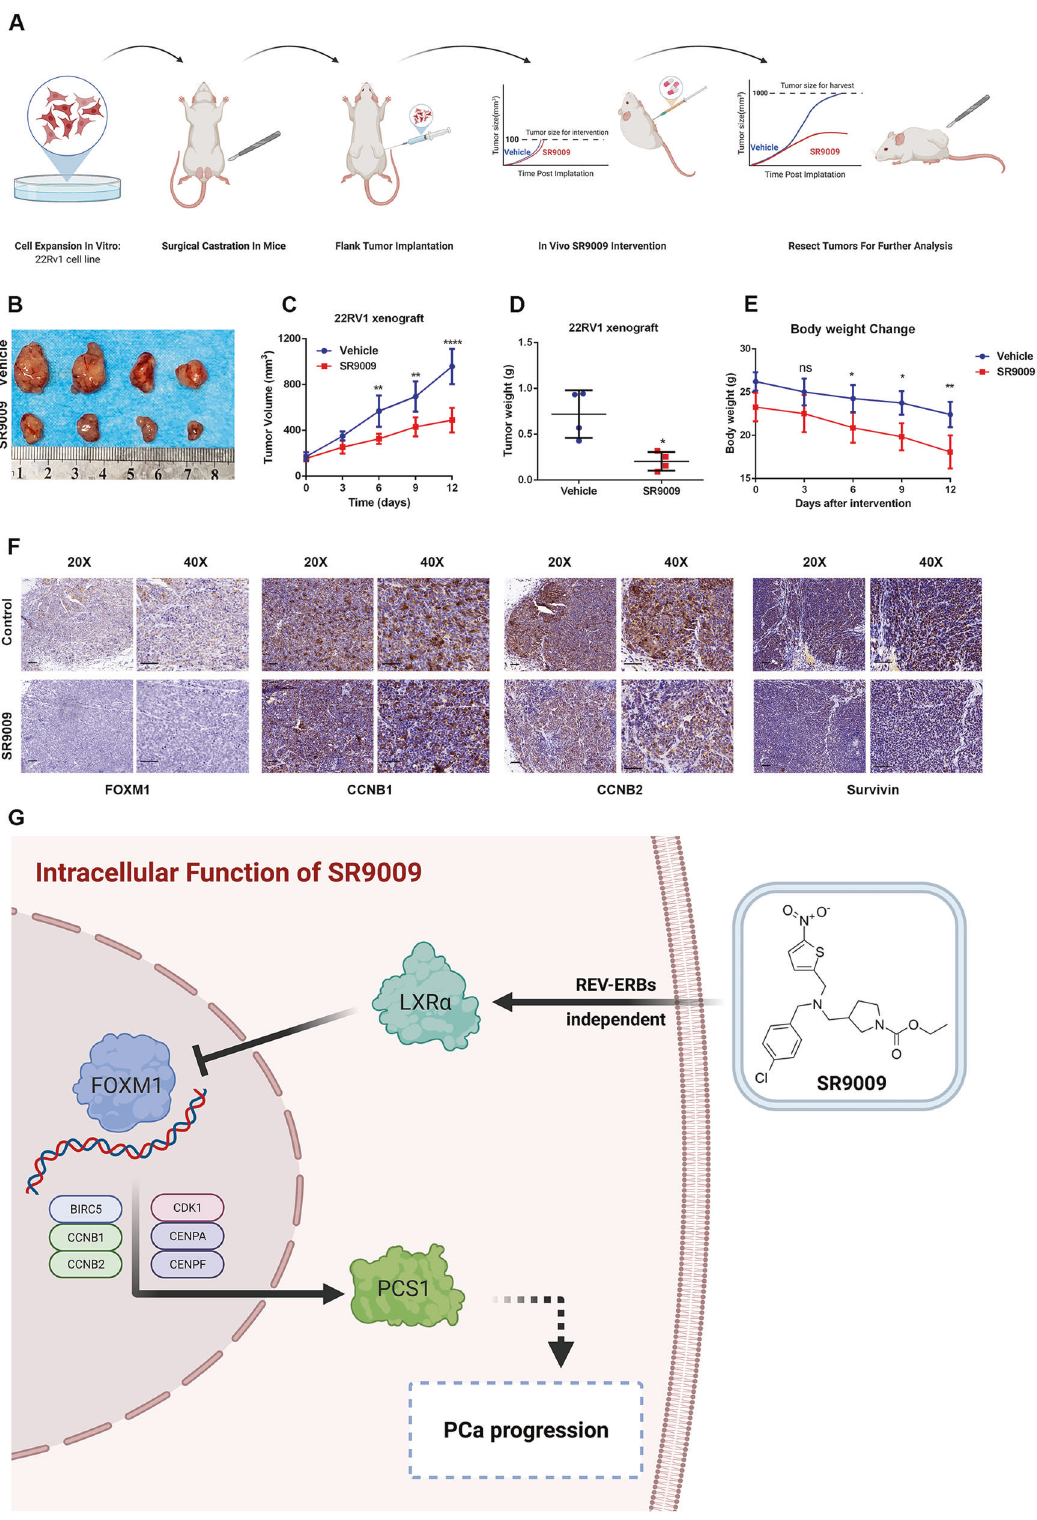
Fig. 7 SR9009 impaired PCa tumor growth and blocked the FOXM1 pathway in vivo. A Experimental procedure of subcutaneous 22RV1 xenograft model building. B Tumor sizes were signi fi cantly lower in the SR9009 group than in the vehicle group. SR9009 was administered at a dose of 100 mg/kg twice per day via intraperitoneal injection. C SR9009 impaired PCa tumor growth; n = 4; means ± SDs; ANOVA D tumor weights were markedly lower in the SR9009 group than in the vehicle group; n = 4; means ± SDs; unpaired t test. E SR9009 reduced mouse body weight; n = 4; means ± SDs; ANOVA. F Immunohistochemistry showed that SR9009 downregulated the expression of FOXM1, CCNB1, CCNB2, and survivin. G Schematic model of the regulatory network of SR9009 in PCa. Data are expressed as the means ± SEMs. ns not signi fi cant; * p < 0.05; ** p < 0.01; *** p < 0.001; **** p < 0.0001.